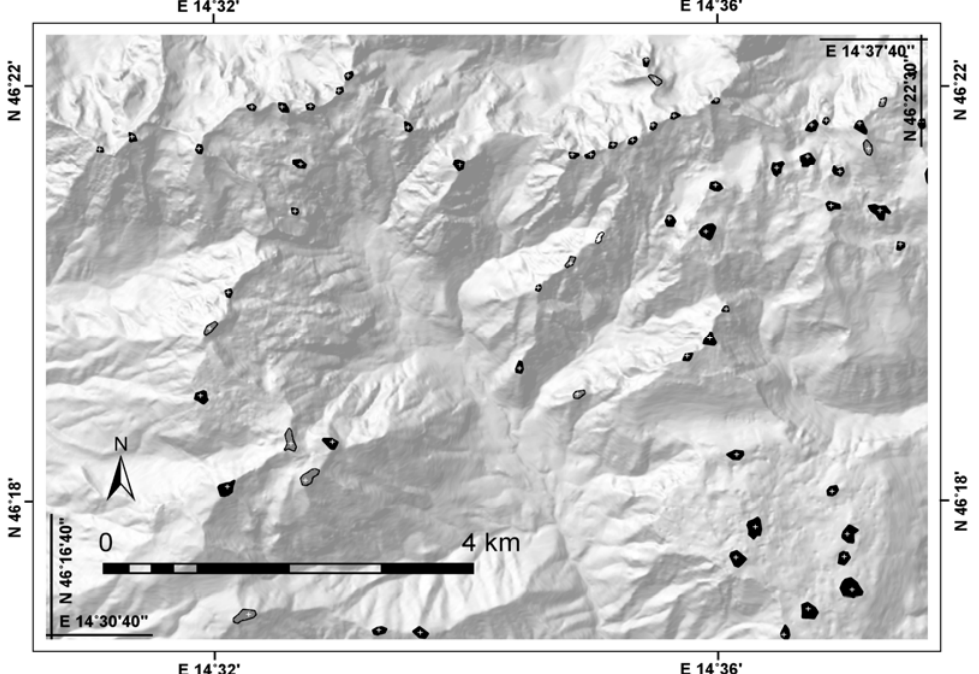
Figure 6. CA based on the slope of the DEM, calculated for a cost distance, equivalent to 100 m form the peaks (white crosslets). The black areas are nearly circular, the grey are oblong (1:2) and white are oblong to a greater degree (1:3) Smaller areas denote sharper or rougher peaks. A zoomed-in area is present (see Figure 7) with dimensions of 13 km × 9.5